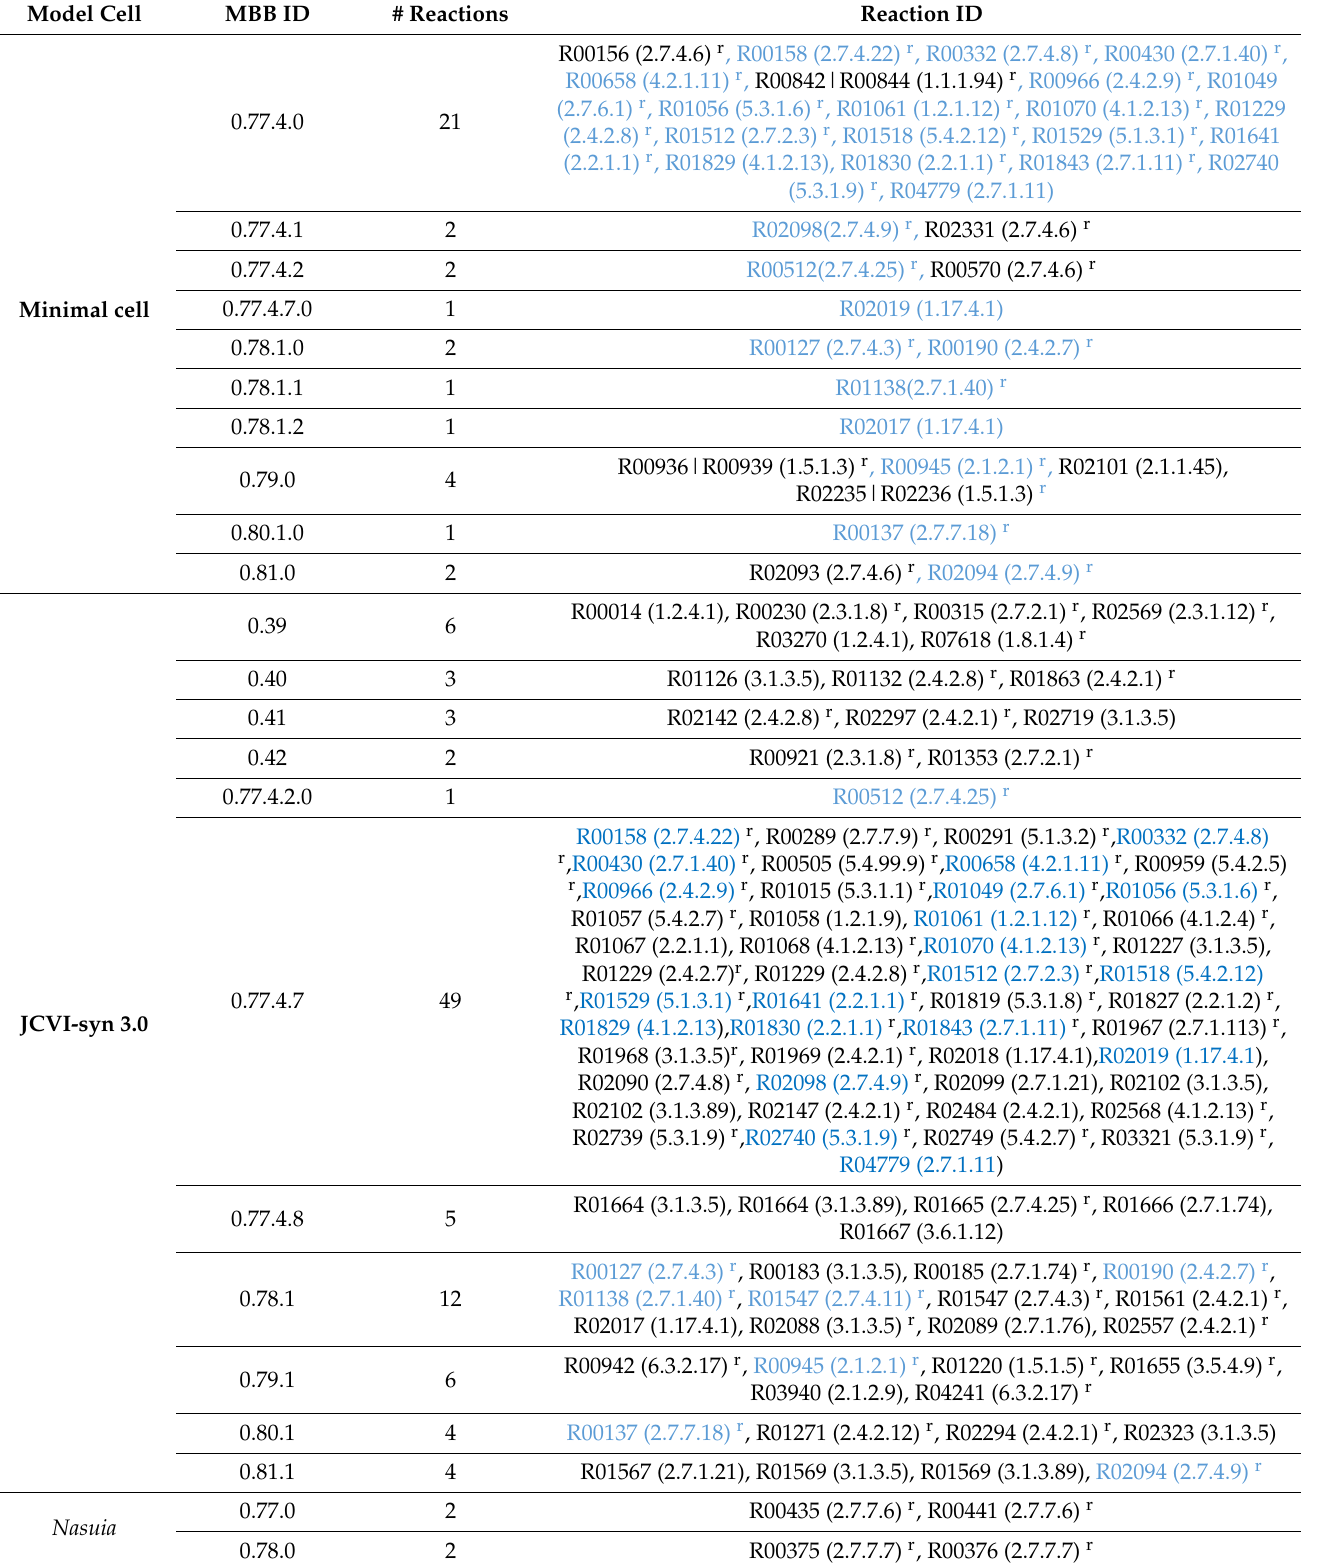
Table 5. Comparison of the MBBs of the three networks under study. Every row lists the reactions belonging to the corresponding MBB and the enzymes involved in those reactions. The list includes only MBBs composed of at least three reactions (reverse included) or with fewer reactions but that are shared by at least two of the networks under